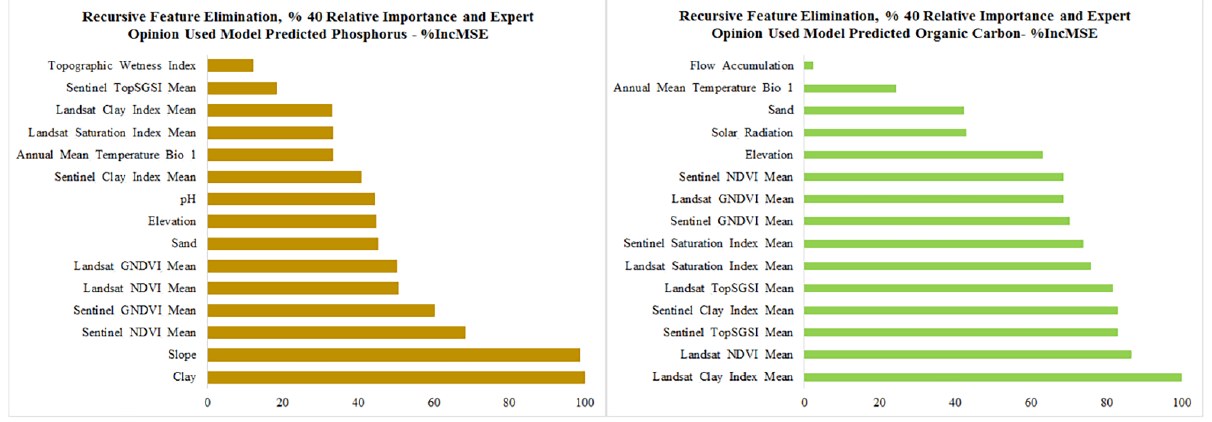
Figure 8. Variable importance: on the left for phosphorus using random forest; on the right for organic carbon using random forest (X axis: percent increase in mean square